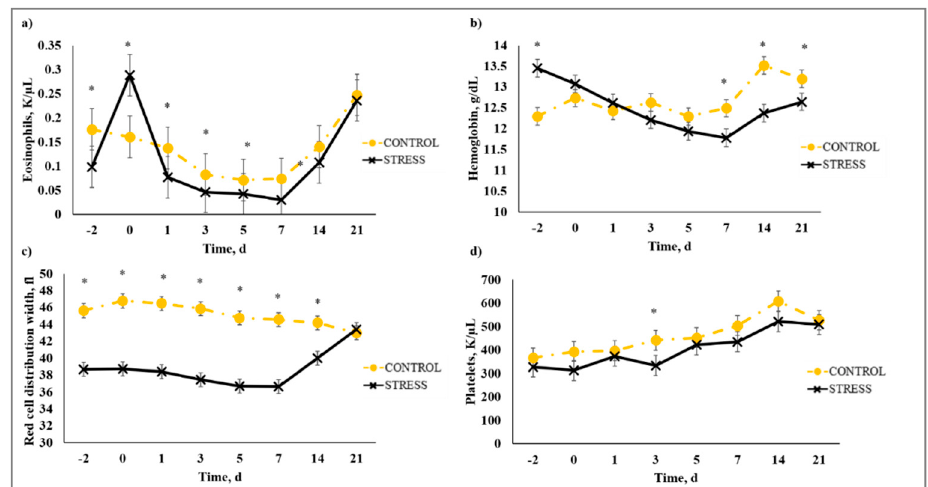
Figure 7. Effect of non-stress control (C; weaned on Day − 37; transported to West Texas A&M University research facility on Day − 21; vaccination on Day 0) and stress model implementation (S: weaned on Day − 3; transported to USDA-ARS Livestock Issues Research Unit on Day − 2; relocated to WTAMU on Day − 1; vaccination on Day 0) on: ( a ) eosinophils (EOS); ( b ) hemoglobin (HGB); ( c ) red cell distribution width (RDW); and ( d ) platelets (PLT). Effect of stress model implementation on EOS (stress model × day effect; p < 0.01); HGB (stress model × day effect; p < 0.01); RDW (stress model × day effect; p < 0.01); PLT (stress model × day effect; p < 0.02). * C differs from S within day, p ≤ 0.05.